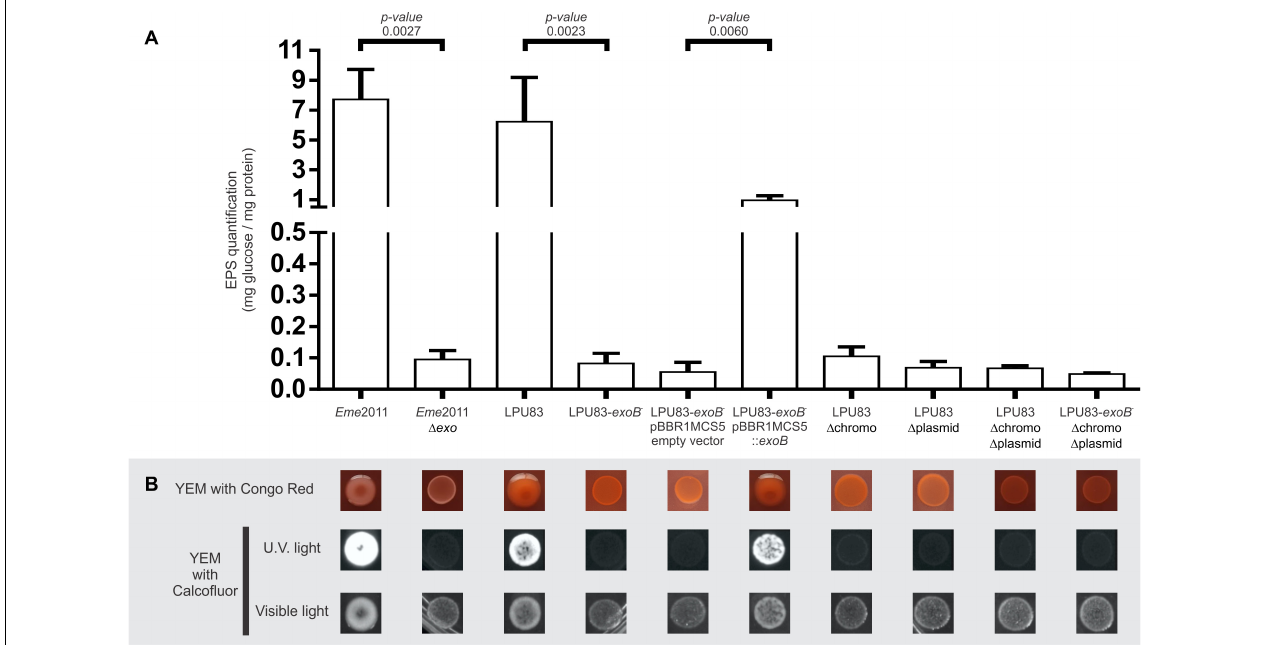
FIGURE 4 | Characterization of EPS production of LPU83 mutants. (A) EPS quantification by the anthrone method. The EPS amount normalized per mg of total proteins is shown for each evaluated strain of E. meliloti and R. favelukesii . (B) Phenotypic analyses of the LPU83 mutants. EPS production was evaluated in YEM with Congo Red (first line) and in YEM with calcofluor under visible light and under UV light (lines below). The presence of EPS I is evidenced in the last condition due to its fluorescence. The statistical analysis was done by a t -test using three independent biological replicates. Representative pictures of at least three different experiments are